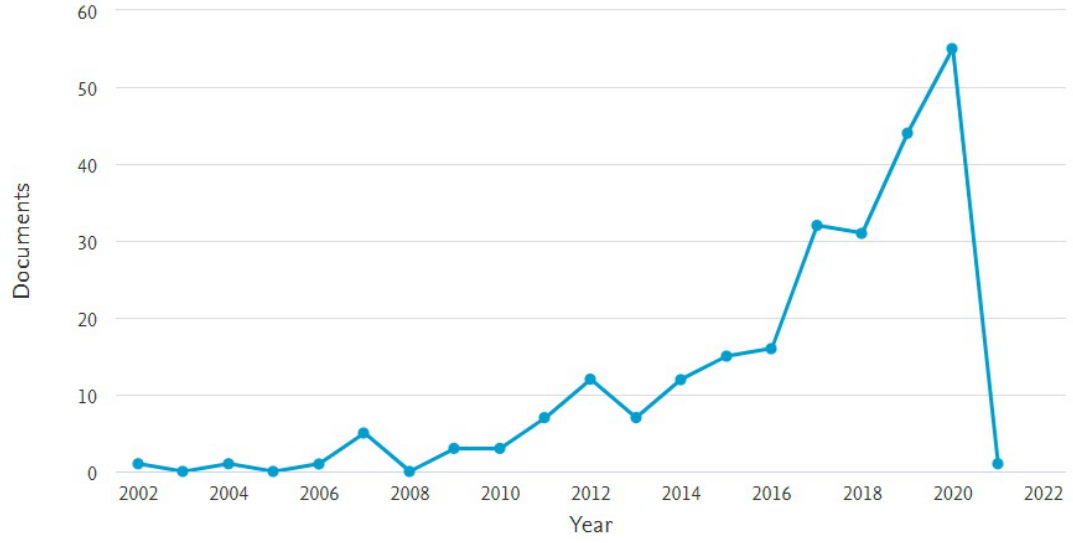
Figure 1. Search results for hyperscanning on